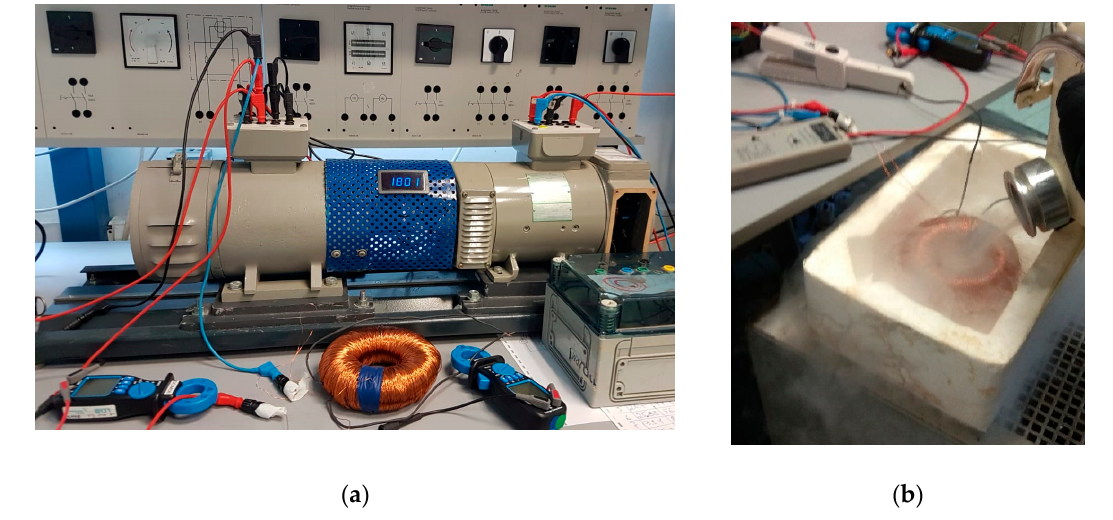
Figure 4. ( a ) Experimental setup for coupling measurement, ( b ) coil immersed in liquid nitrogen.